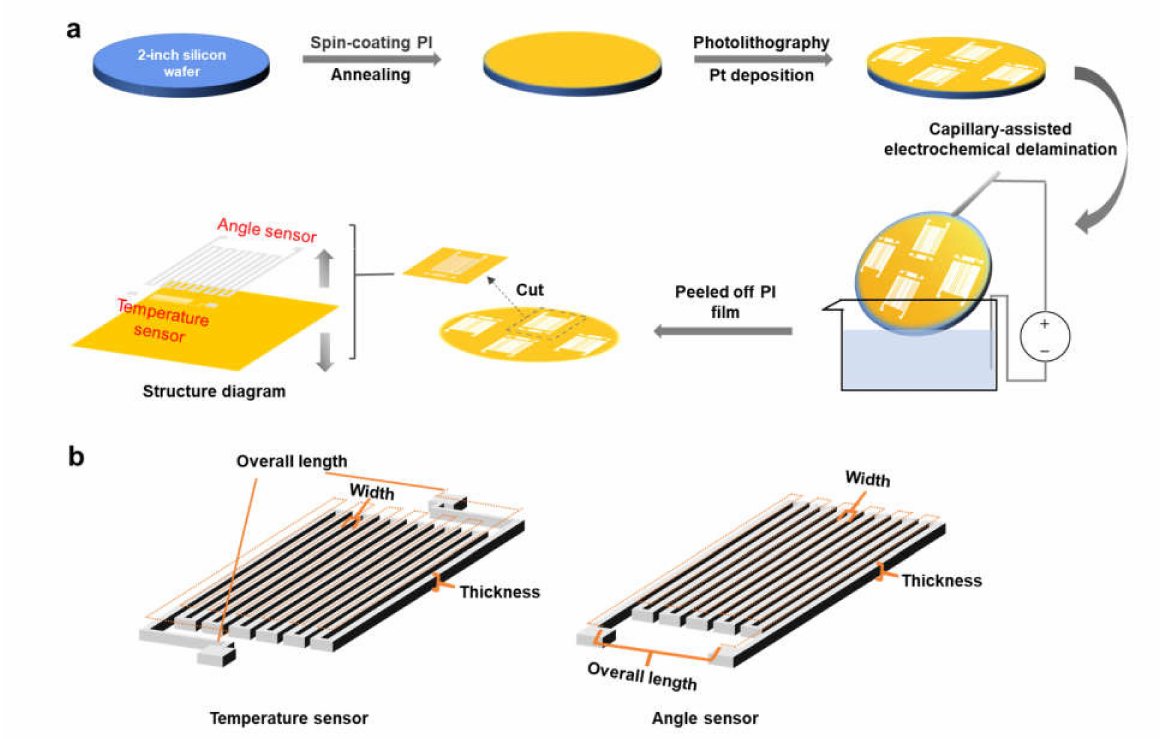
Figure 1. Schematic illustration of ( a ) the fabrication procedures and ( b ) a temperature sensor and an angle sensor marked with design